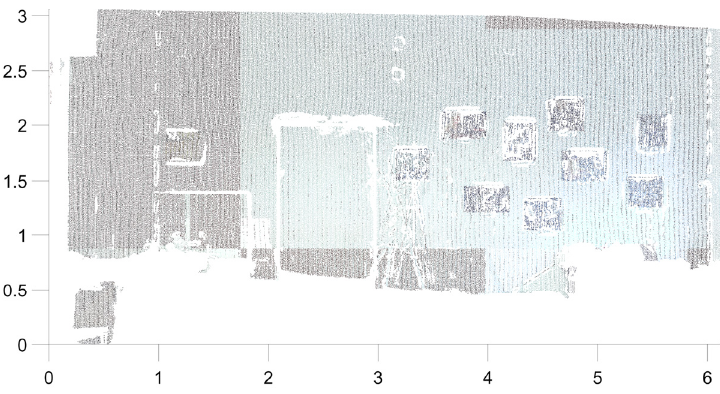
Figure 7. Segmented point cloud—after the normal-based filtration.